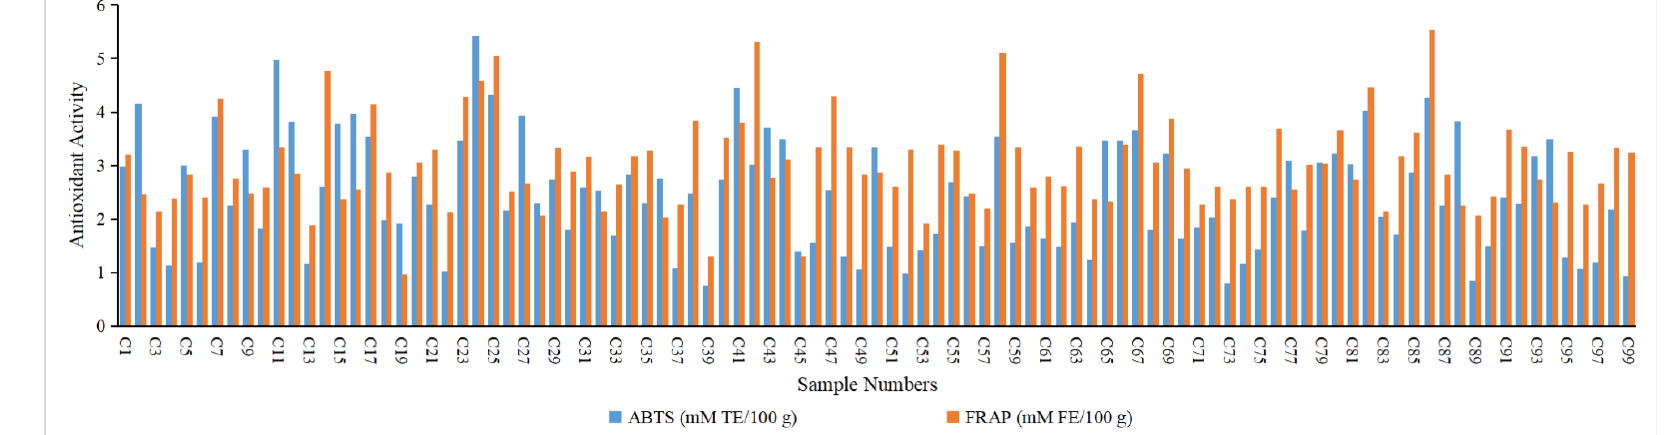
Figure 4. The antioxidant activities of the extracts of different jujube samples. ABTS = 2,2-azinobis (3-ethylbenzothiazoline-6-sulphonic acid) FRAP = ferric reducing antioxidant power kit. Table 4. Correlation coefficients (r) of the studied triterpenic acids and the antioxidant activity of jujube cultivars.